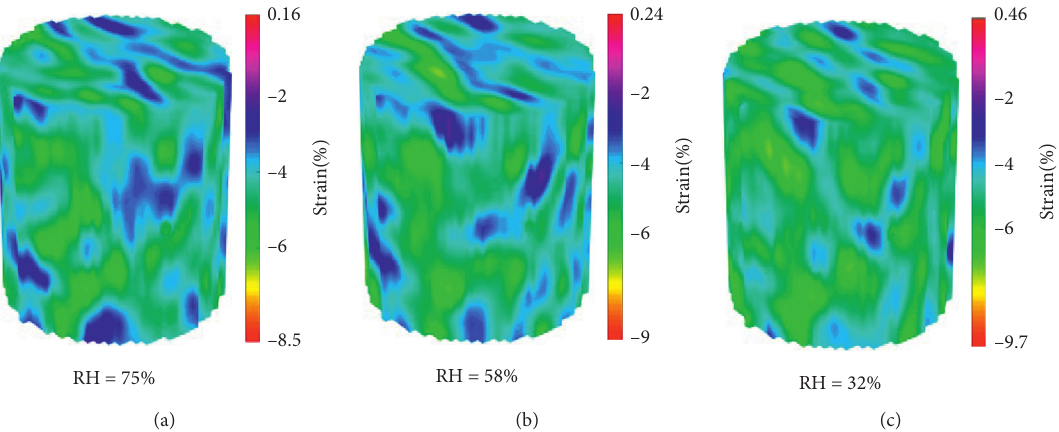
Figure 5: Strain ( ε xx ) in sample No. 1 during dehydration: (a) from 98% to 75%; (b) from 98% to 58%; (c) from 98% to 32% (“+” means dilatation and “ − ” means